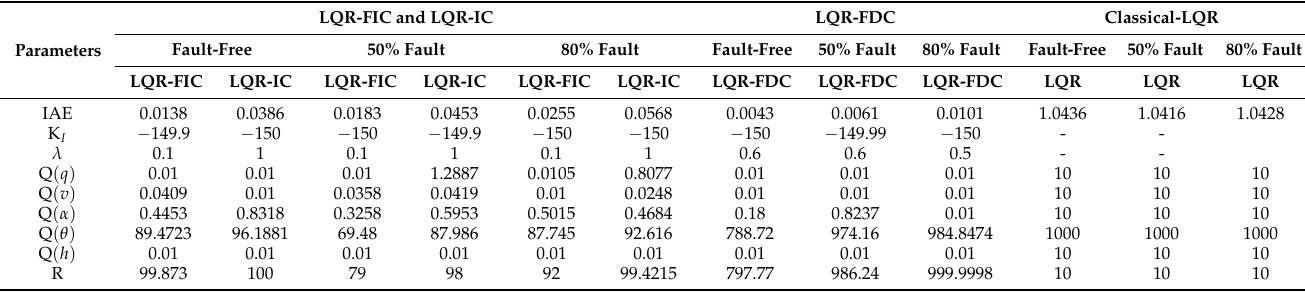
Figure 3. ( a ) Open − loop step responses of augmented pitch angle control-fractional integral, and ( b ) open − loop step response for augmented pitch angle control − fractional derivative. Table 1. The numerical results of the proposed controller − based fractional integral/fractional compensator: fault − free and faulty